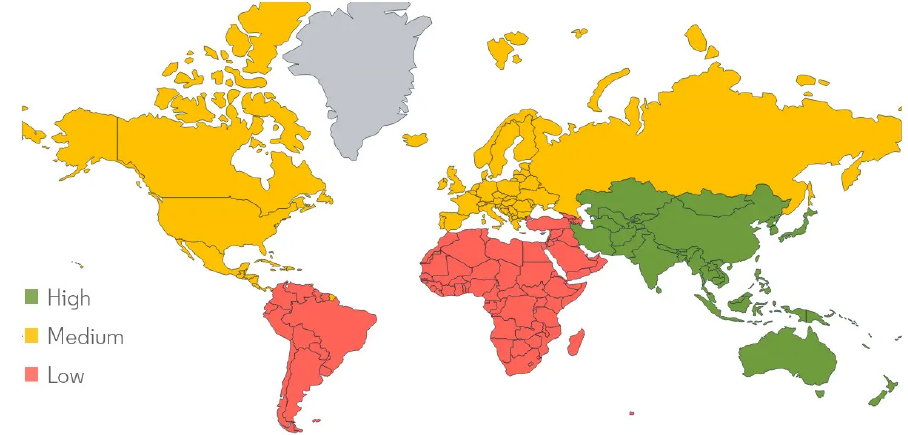
Figure 4. Building-integrated photovoltaics (BIPV) market growth rate by region, 2020–2025 [16].